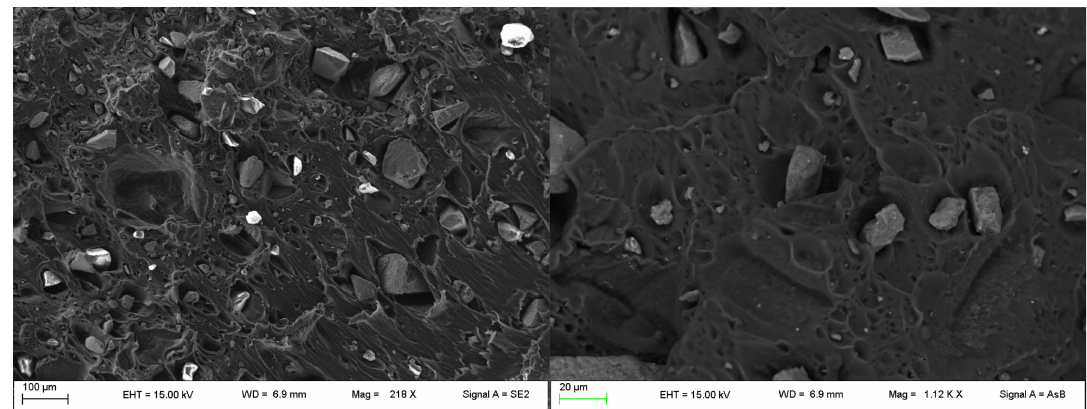
Figure 6. FE-SEM micrographs of the PEOT/PBT ZrP-GTM 20 wt % composite.